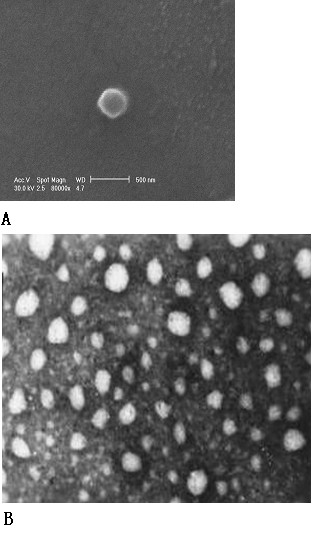
The core-shell structure of 5-FU/PEG-PBLG nanoparticles. (A) Morphology under SEM (× 80000). SEM showed 5-FU/PEG-PBLG nanoparticles have a core-shell structure, a spherical or elliptical shape, and a smooth surface. The hydrophobic central core is a non-gilt grizzly area, about 200 nm in diameter and the hydrophilic shell is a gilt white area, about 30 nm in thickness. (B) Morphology under TEM (× 50000). TEM showed that nanomicelles were round or oval particles of uniform size with fuzzy edges.